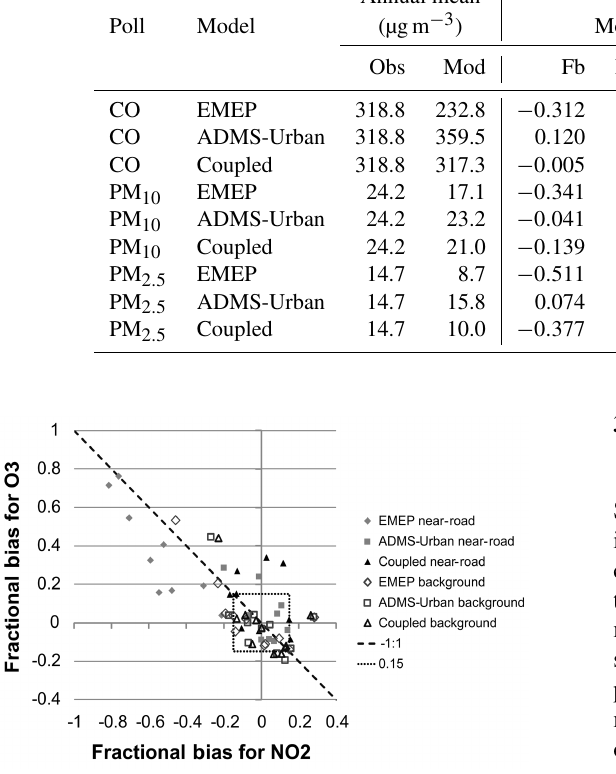
Figure 8. Scatter plot comparing annual average fractional bias for NO 2 and O 3 for each of the 20 sites where O 3 is measured, for each model. The dotted line represents a fractional bias of 15%, which is the required maximum measurement uncertainty under directive 2008/50/EC (EC Directive,